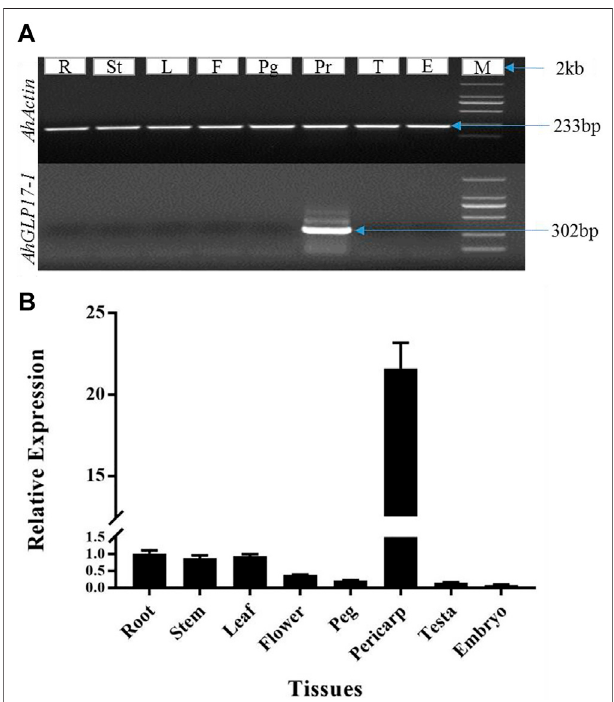
FIGURE 2 | Expression analysis of AhGLP17-1 gene expression in different tissues. (A) Semiquantitaive PCR-based expression analysis, (B) qRT-PCR-based expression analysis of AhGLP17-1 gene expression. Both semiquantitative and qRT-PCR results are consistent with transcriptome and microarray expression data (as shown in Figure 1A ). L (cid:1) leaf, St (cid:1) stem, Fl (cid:1) fl ower, Em (cid:1) embryo, Ts (cid:1) testa, peg (cid:1) peg/ gynophore, peri (cid:1) pericarp, and R (cid:1) root. Root expression was used as a control to analyze the data.